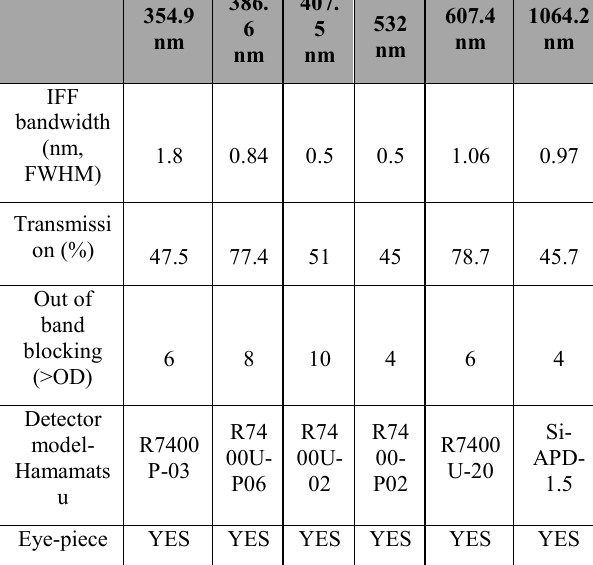
Figure 2 . The 532 nm LRSU elastic depolarization lidar (AIAS